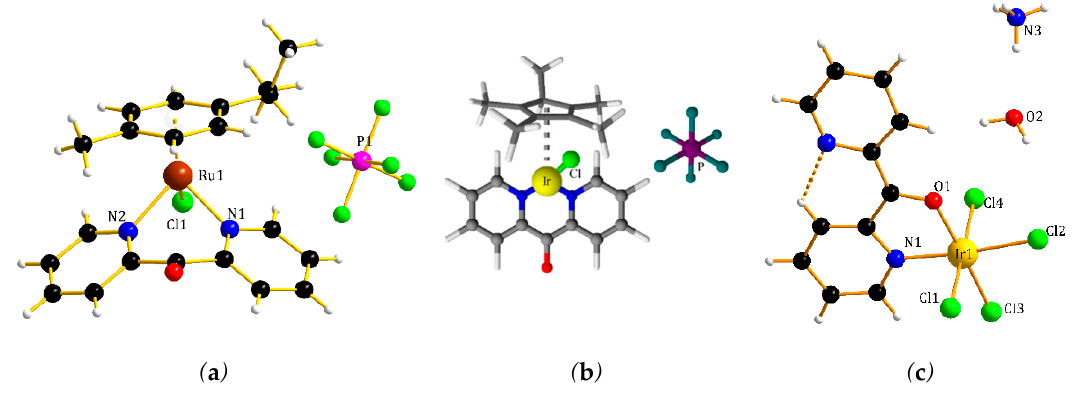
Figure 1. Molecular structures of complexes: ( a ) 1 ; ( c ) 3 ; ( b ) 2 with proposed structure of complex.